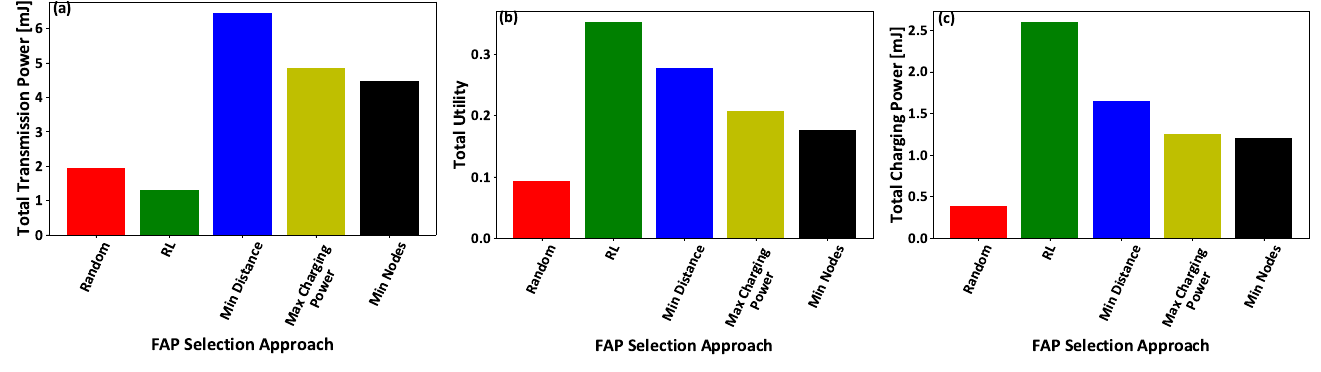
Figure 8. ( a ) Total transmission power and ( b ) utility of all the IoT nodes, and ( c ) total charging power of all the FAPs — A Comparative